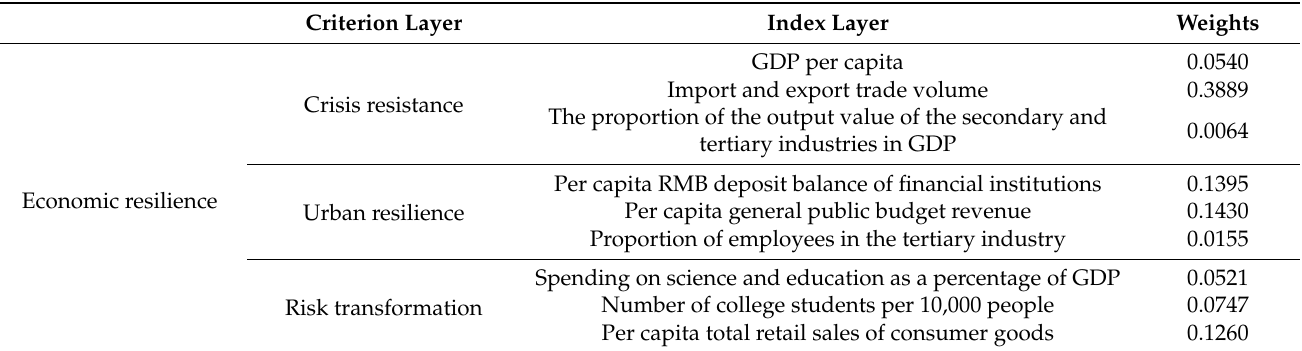
Table 1. Urban Economic Resilience Index